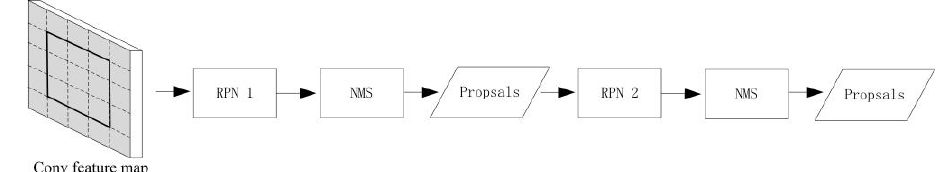
Figure 5. The structure of the cascade RPNs.